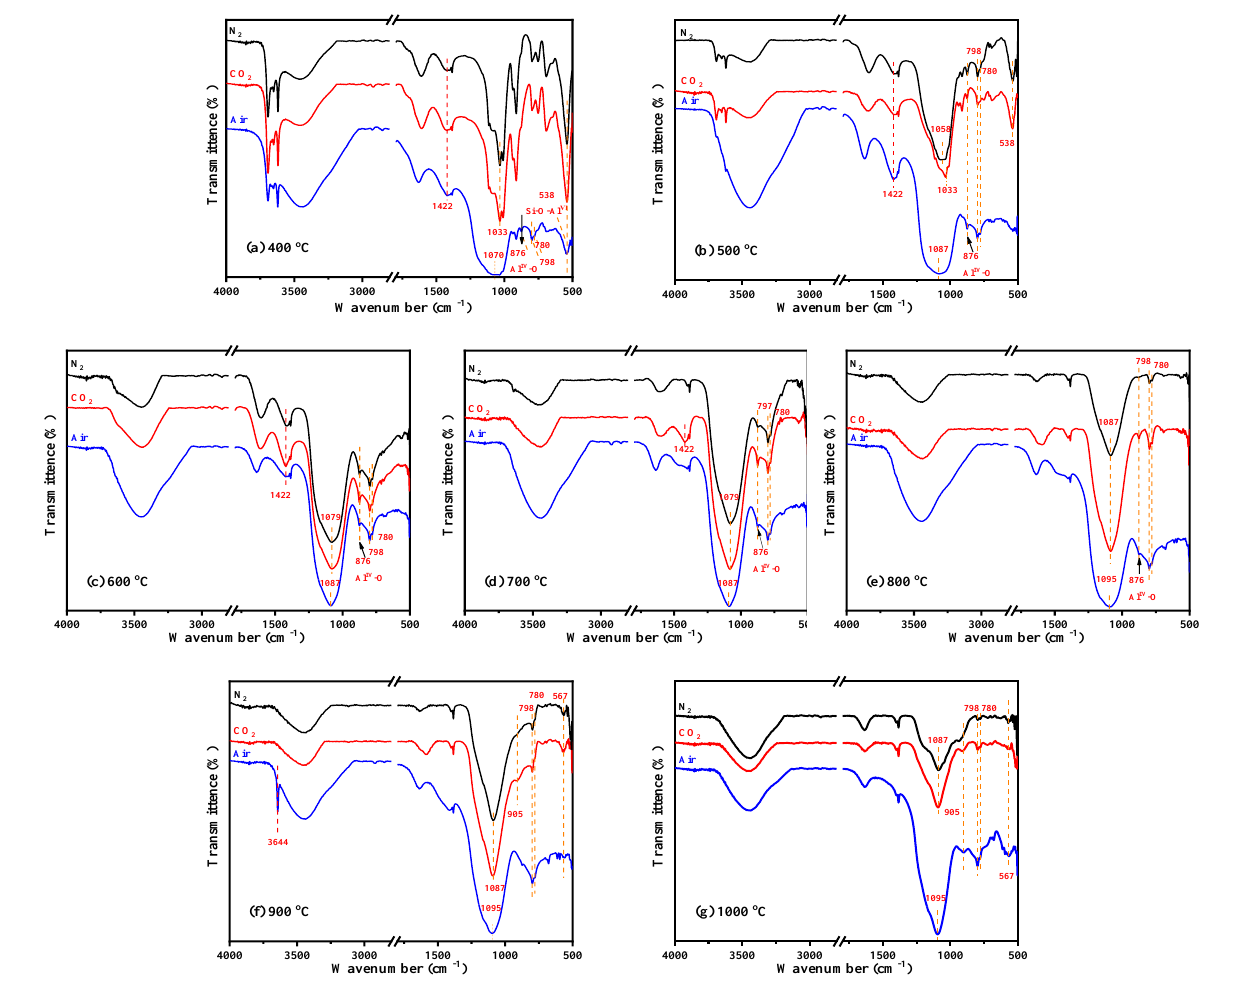
decomposition rate was 91.5%, but under N 2 and CO 2 atmospheres, the decomposition rates were only 66.7% and 38.1%, respectively. Moreover, the complete decomposition of kaolinite was achieved at 600 °C under each atmosphere. The results were consistent with the TGA-DTG-DSC analysis, indicating that compared with N 2 and CO 2 atmospheres, air atmosphere was more conducive to the low-temperature decomposition of kaolinite. As for kaolinite, the combustion of carbon also contributed to the decomposition of pyrite and calcite, so at the same calcination temperature, the decomposition rate of pyrite and calcite under air atmosphere was highest than that under N 2 and CO 2 (Figure 7b,c). Moreover, the decomposition of calcite was also restrained by the CO 2 atmosphere, which was because the decomposition of calcite is very sensitive to the partial pressure of CO 2 , and the higher partial pressure of CO 2 in the system pushed the decomposition of calcite Figure 6. FTIR spectra of KAS calcined at 400 ◦ C to 1000 ◦ C under different atmospheres: ( a ) 400 ◦ C, towards a higher temperature. The decomposition reactions of pyrite and calcite are show Figure 6. FTIR spectra of KAS calcined at 400 °C to 1000 °C under different atmospheres: ( a ) 400 °C, ( b ) 500 °C, ( c ) 600 °C, ( d ) 700 °C, ( e ) 800 °C, ( f ) 900 °C, ( g ) 1000 °C. ( b ) 500 ◦ C, ( c ) 600 ◦ C, ( d ) 700 ◦ C, ( e ) 800 ◦ C, ( f ) 900 ◦ C, ( g ) 1000 ◦ C. in (SI 16 – 17). From Figure 5, it can be seen that the calcination temperature and atmosphere had a great influence on the decomposition of minerals in the KAS. Quartz was stable during calcination; however, kaolinite, pyrite, and calcite showed different residual structures as a function of temperature under the three calcination atmospheres. To quantify, the rela- tive decomposition rate of the three minerals was calculated using the change in the in- tensity of the diffraction peak of kaolinite, pyrite, and calcite relative to the intensity of the peak of quartz, respectively [6]. The formula is listed as follow: